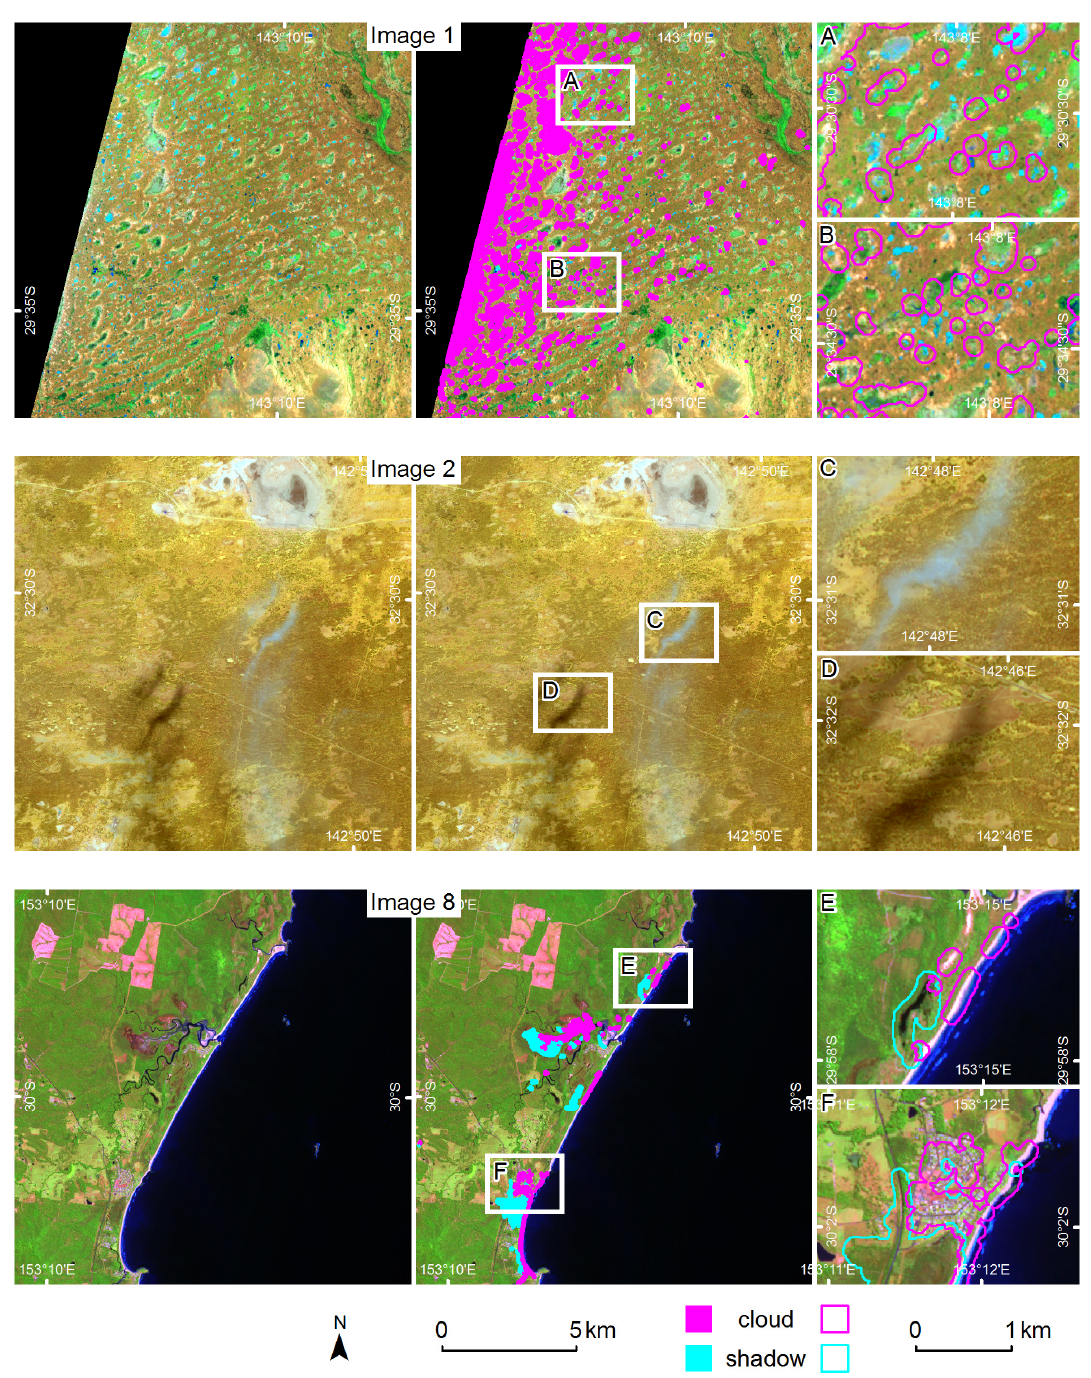
Figure 11. Examples of SPOTCASM cloud and shadow masks performed poorly, from subsets of images numbered in Figure 1. All images are shown with bands 4, 3, 1 as red, green and blue. Image 1 ( A , B ). Image 2 ( C , D ). Image 8 ( E , F